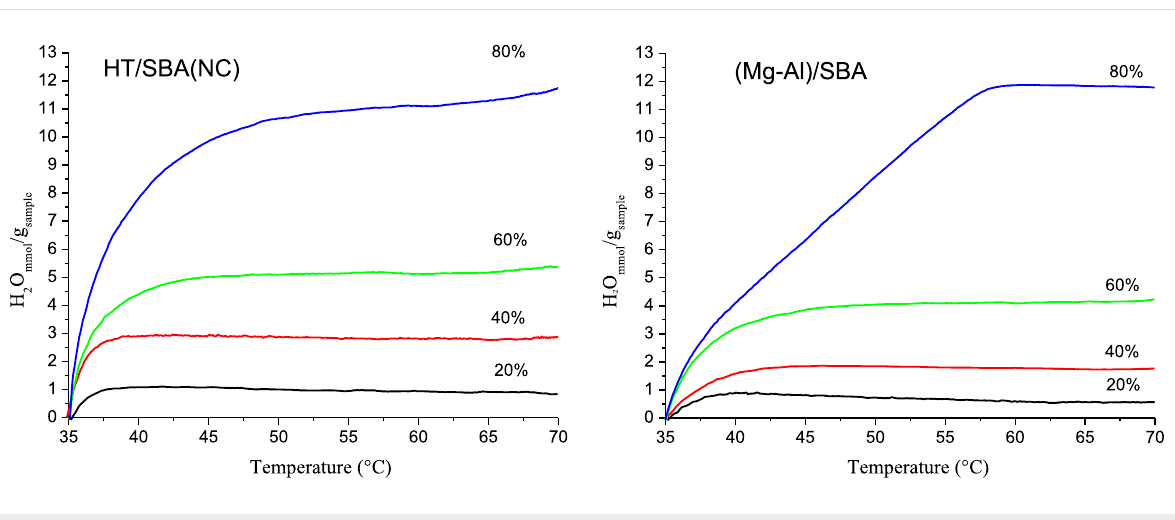
Figure 6: Adsorption of water vapor at different relative humidity values versus increase of temperature from 35 to 70 °C of the HT/SBA(NC) and (Mg/Al)/SBA